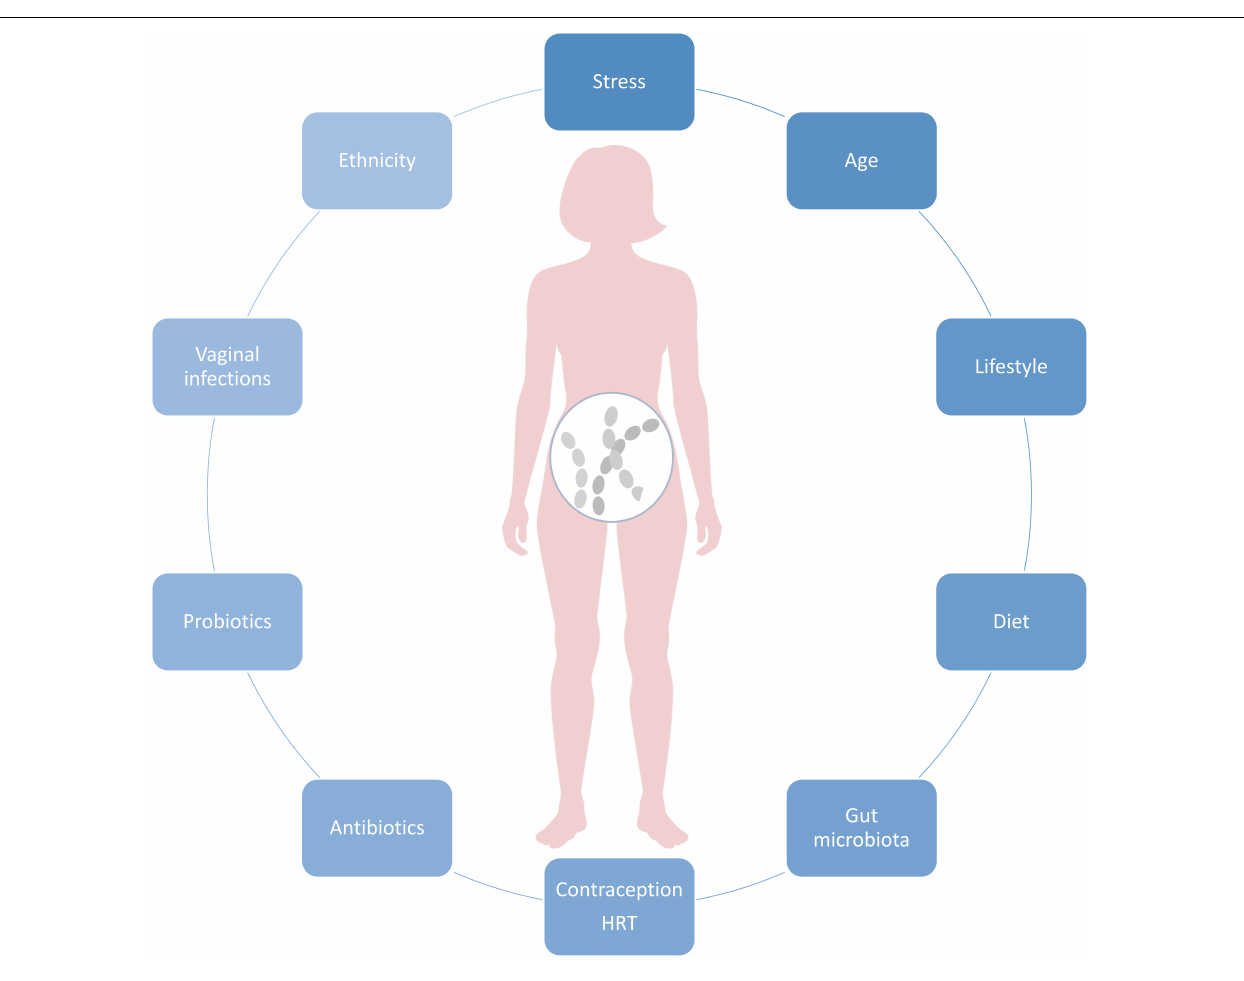
FIGURE 1 | Key factors affecting vaginal microbiota